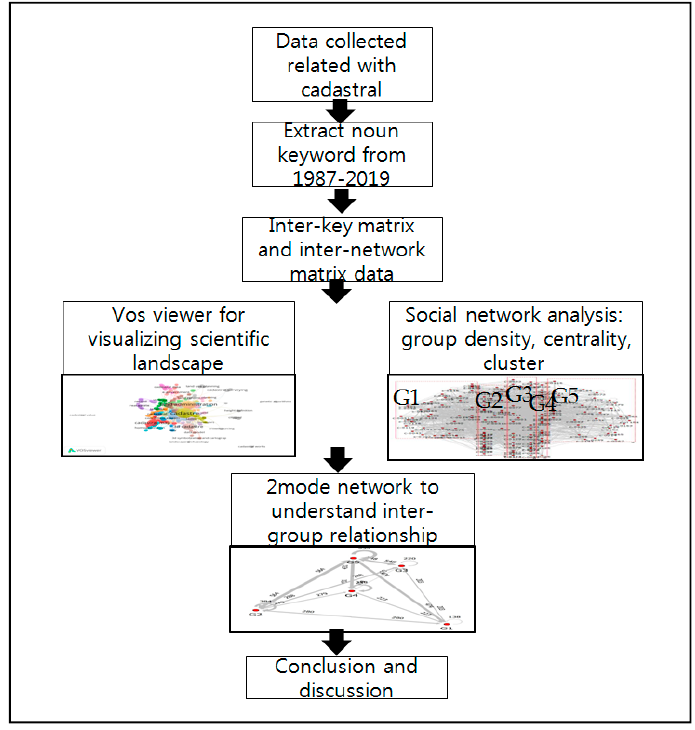
Figure 1. Research process.